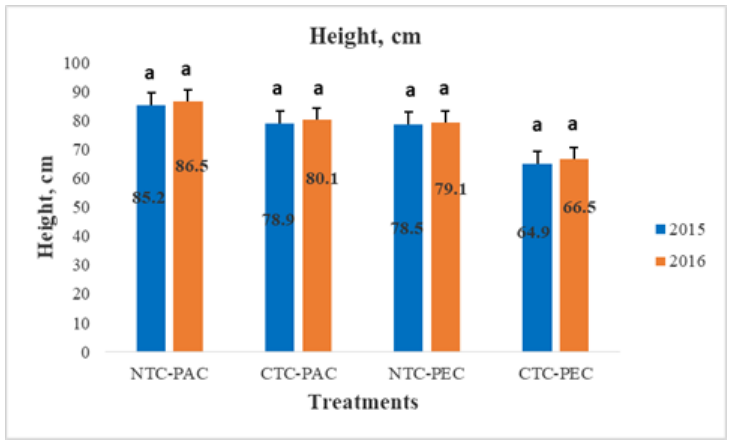
Figure 2. Plant height (cm) of sunflower cultivation for the two growing years. Different letters at each column denote statistically significant difference of means according to the LSD test for 95% significance level ( p < 0.05). NTC-PAC: no tillage planting parallel to the contour direction. CTC- PAC: conventional tillage planting parallel to the contour direction. NTC-PEC: no tillage planting perpendicular to the contour direction. CTC-PEC: conventional tillage planting perpendicular the contour